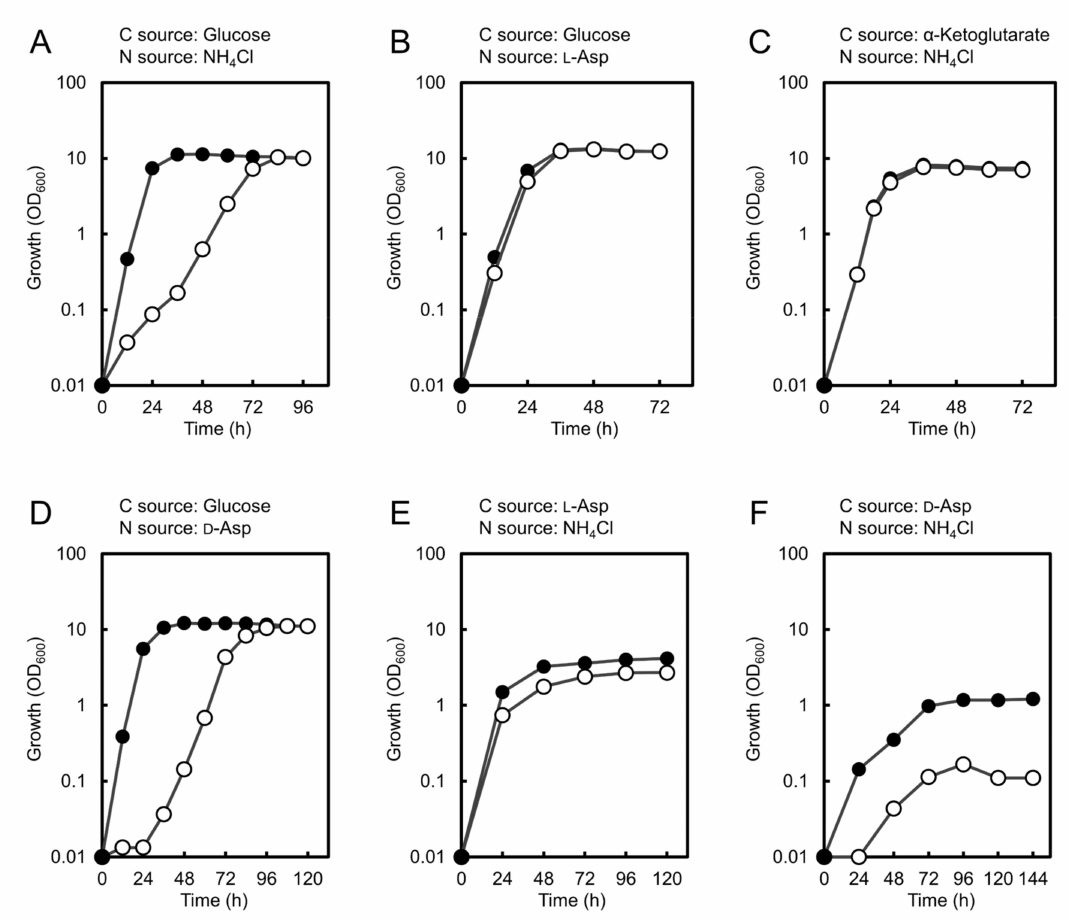
Figure 4. Growth of the wild-type and ∆ Chpyc1 strains on media containing different carbon and nitrogen sources. The wild-type (strain UJ1, closed circle) and ∆ Chpyc1 (open circle) strains were grown in YNB w/o AA and AS media containing either 10 mM NH 4 Cl, L -Asp, or D -Asp as the sole nitrogen source with either 55.5 mM glucose or 66.6 mM α -ketoglutarate as carbon source ( A – D ); and in media containing 10 mM ammonium chloride as nitrogen source with either 83.3 mM L -Asp or D -Asp as carbon source ( E , F